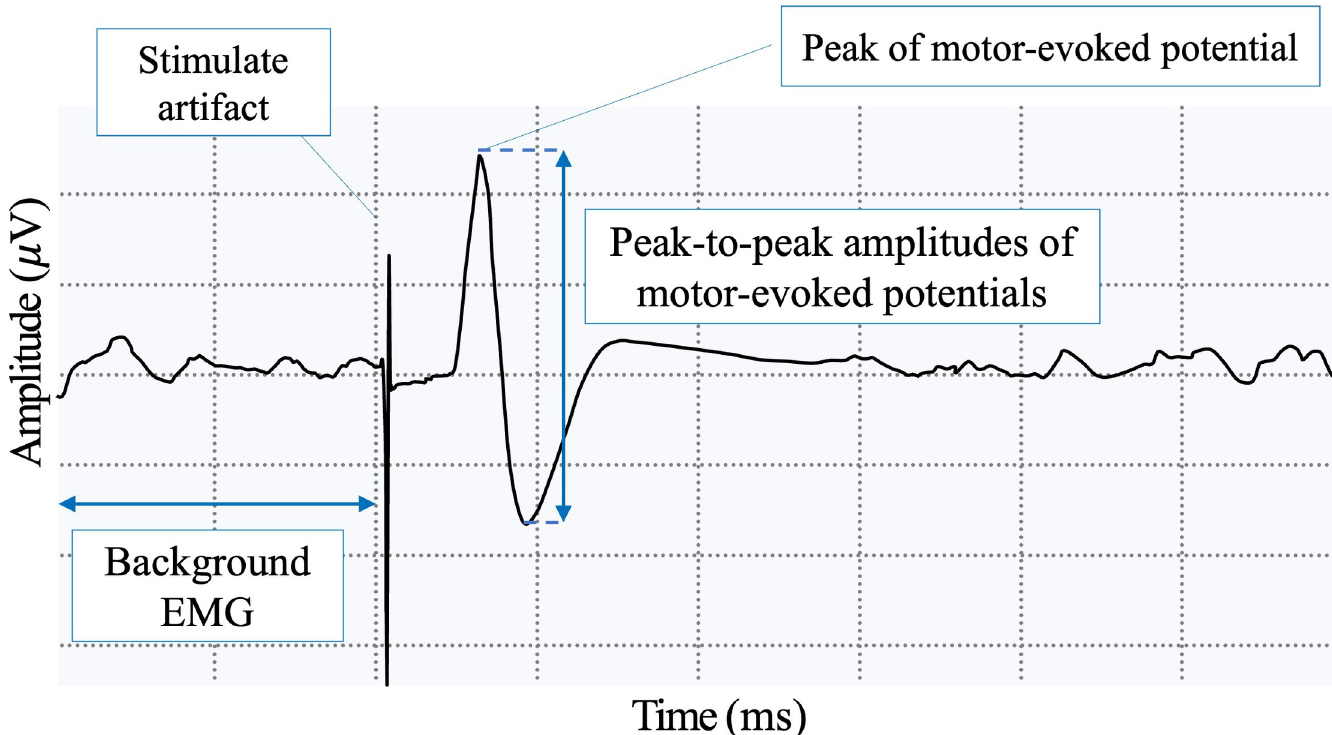
Fig 2. A typical motor-evoked potential of upper